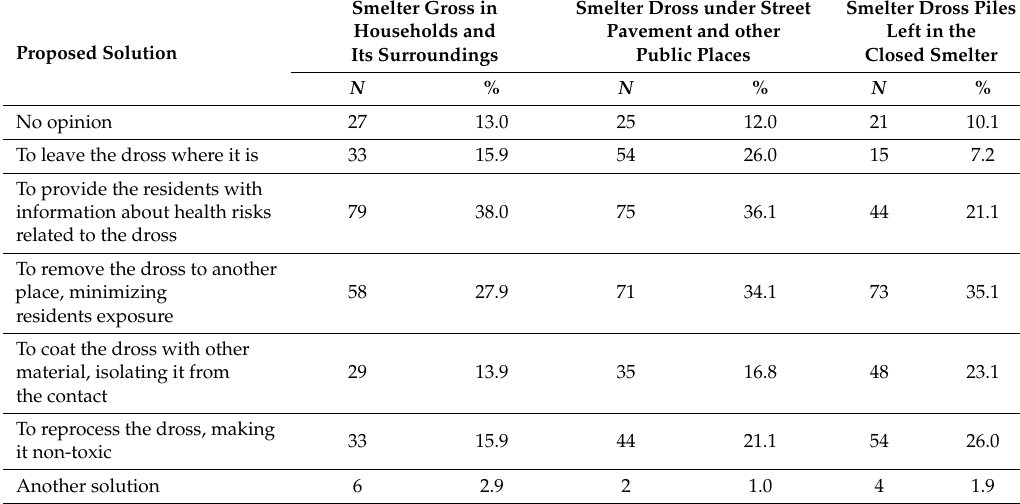
Table 3. The solutions proposed for smelter dross management present in the three different environmental settings according to the opinion of 208 residents in Santo Amaro City, 2008.